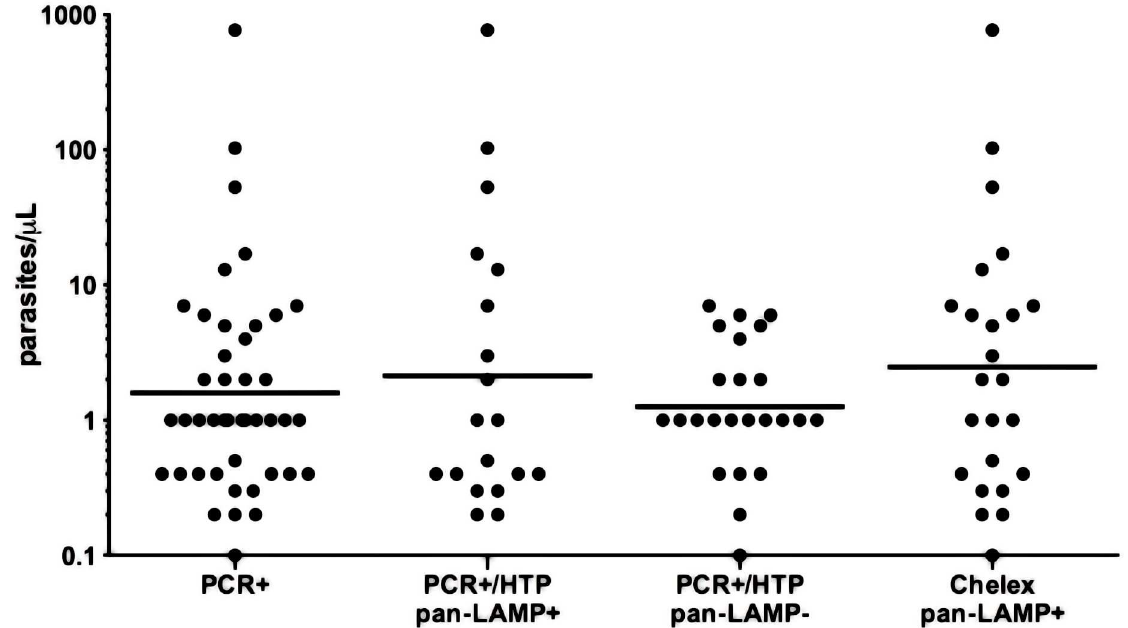
Fig 2. Distribution of quantitative PCR determined parasite densities. pan- Pan plasmodium , Geometric mean values are indicatedby horizontal lines. Geometric mean values are for PCR + 1.8 p/ μ L (range 0.1–770),for PCR+/ pan HTP-LAMP + 2.5 p/ μ L (range 0.2–770), for PCR+/ pan-HTP-LAMP– 1.4 p/ μ L (range 0.1–7) and for Chelexpan-LAMP+ 3.4 p/ μ L (range 0.1–770).